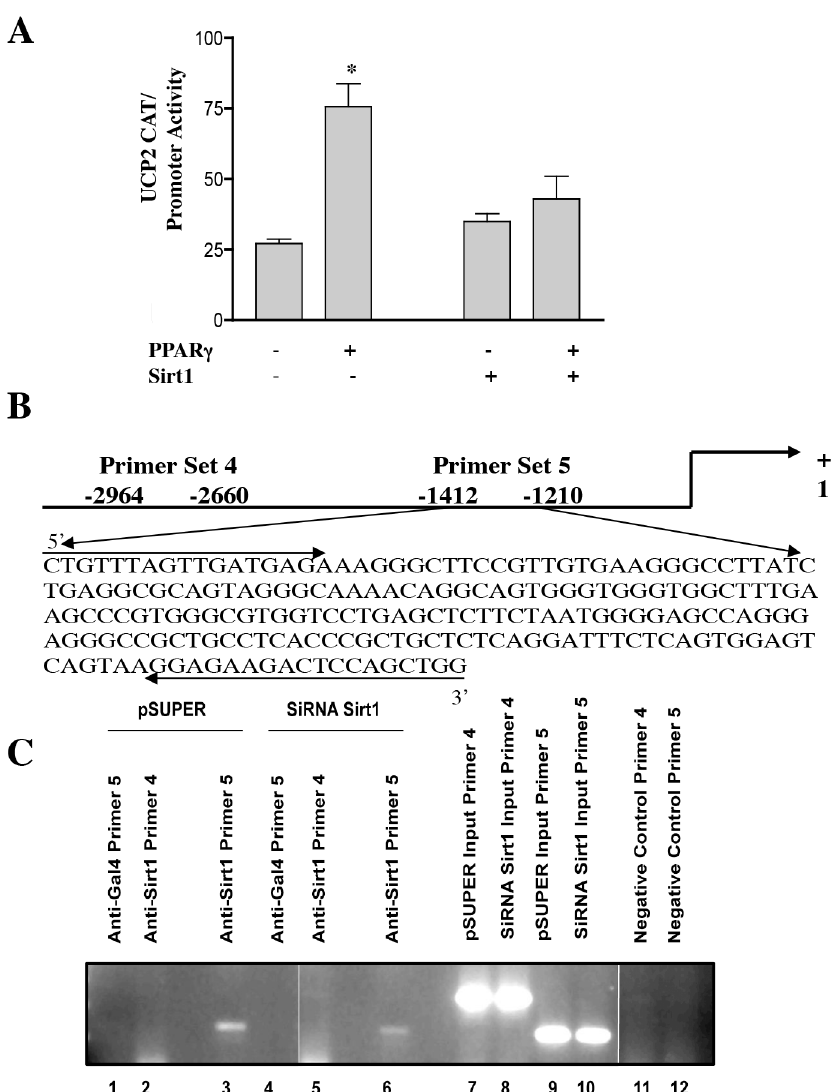
Fig 5. Sirt1 Binds at the UCP2 Promoter and Represses the Gene. (A) In vitro CAT assay. 293T cells were transfected with a CAT reporter driven by the UCP2 promoter. Cells were also co-transfected with Sirt1 or not and with PPAR γ or not, as indicated. CAT activity was determined ( n = 3 experiments done in triplicate, * p < 0.05 in the no Sirt1 transfection experiment, ANOVA). (B) Schematic representation of the primer sets (arrows) in the UCP2 promoter (shown schematically and with excerpted DNA sequence). (C) Chromatin- immunoprecipitation (IP) was carried out on INS-1 control cells (lanes 1 – 3) or Sirt1 knockdown cells (columns 4 – 6) using Sirt1 antibody or a Gal4 control antibody, as indicated. PCR was carried out with the indicated primers. INPUT (columns 7 – 10) refers to PCR carried out on samples prepared prior to immunoprecipitation. Negative controls for the PCR (minus DNA) are also indicated (columns 11 and 12). In preparing the original panel for publication, the shadow/midtone/highlight input levels in the gray channel were adjusted uniformly to approximately 35/1.00/85 units. Vertical lines indicate where the original gel image was spliced together.